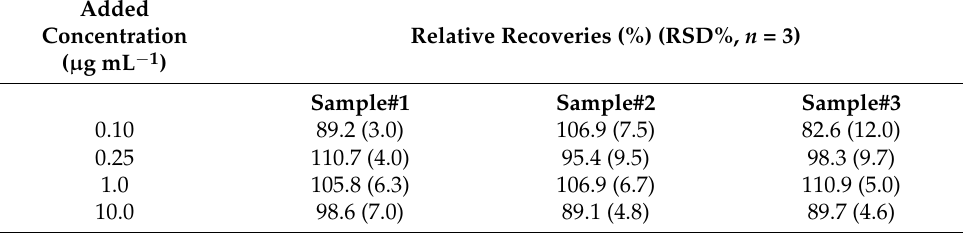
Table 2. Relative recoveries of the studied drug from human urine by the proposed FPSE-HPLC- UV